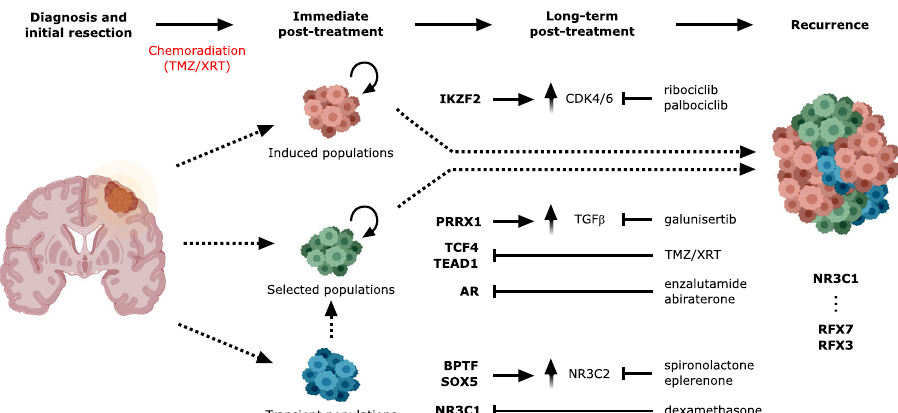
Fig. 4 Comprehensive schematic of glioblastoma progression. Distinct populations of “ induced ” , “ selected ” , and “ transient ” tumor-cells states, regulons, and TFs (bold) contribute to intratumoral heterogeneity, which plays a role in treatment resistance. As cell states may be differentially susceptible to treatment and may be selected for or induced by therapeutic intervention, use of a more complete view of cell state trajectories with scSYGNAL and MINER analysis may allow for the prediction of therapies that work in either the concurrent setting against cell states or an adjuvant/neo-adjuvant setting against induced cell states. Figure components were created via